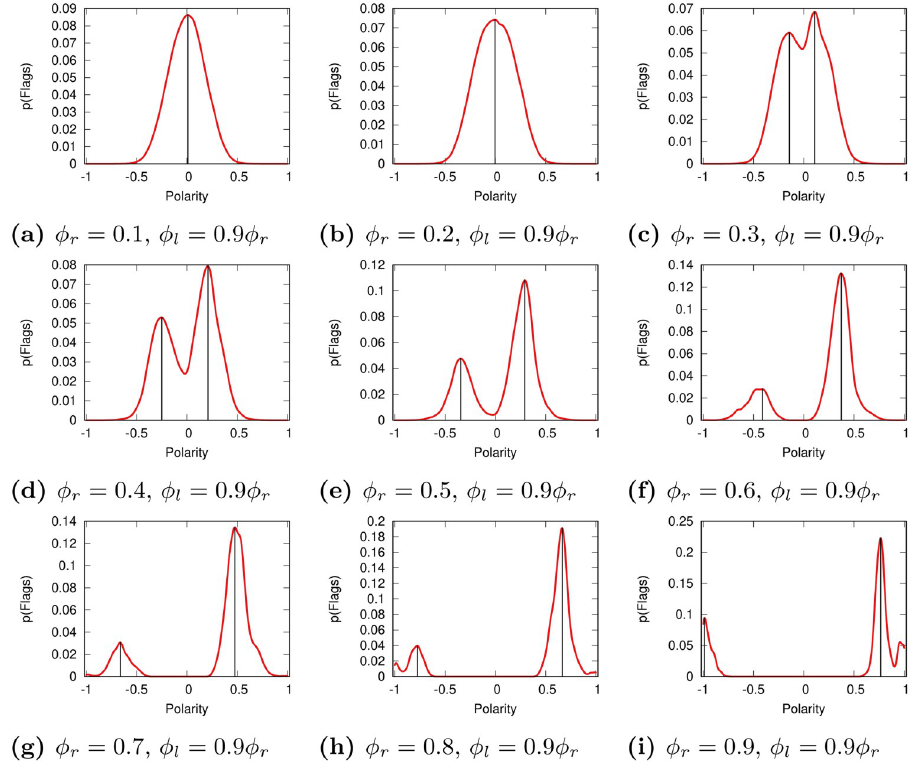
Fig 4. The flag distributions in the Relative model for varying levels of tolerance ϕ legend as Fig 3. (a) ϕ r = 0.1, ϕ l = 0.9 ϕ r . (b) ϕ r = 0.2, ϕ l = 0.9 ϕ r . (c) ϕ r = 0.3, ϕ l = 0.9 ϕ r . (d) ϕ r = 0.4, ϕ l = 0.9 ϕ r . (e) ϕ r = 0.5,